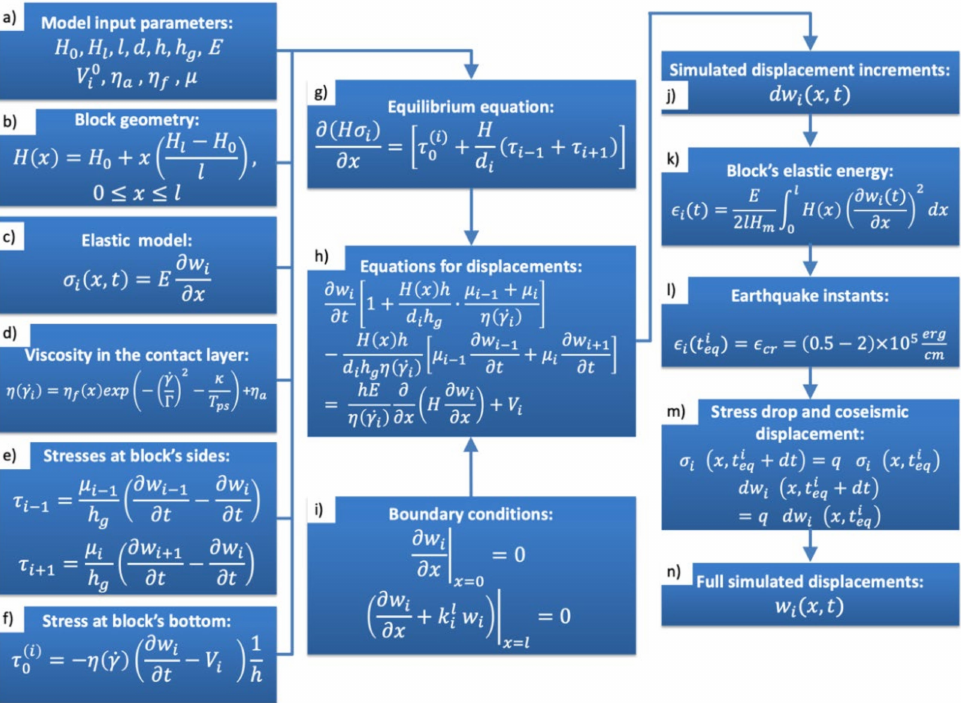
Figure 2. Flowchart showing calculation scheme of the original keyboard model. ( a ) Model input parameters; ( b ) block thickness; ( c ) 1-D elastic model; ( d ) time-dependent viscosity of the contact layer; ( e ) stresses acting on lateral sides of the block; ( f ) stress acting at the block’s bottom; ( g ) stress equilibrium equation; ( h ) equation governing displacement evolution; ( i ) boundary conditions ap- plied at the frontal ( x = 0) and rear ( x = l) edges of the block; ( j ) calculating incremental displacements; ( k ) converting displacements into elastic energy accumulated by the block; ( l ) condition to identify the instant of the earthquake; ( m ) stress dumping conditions; ( n ) output